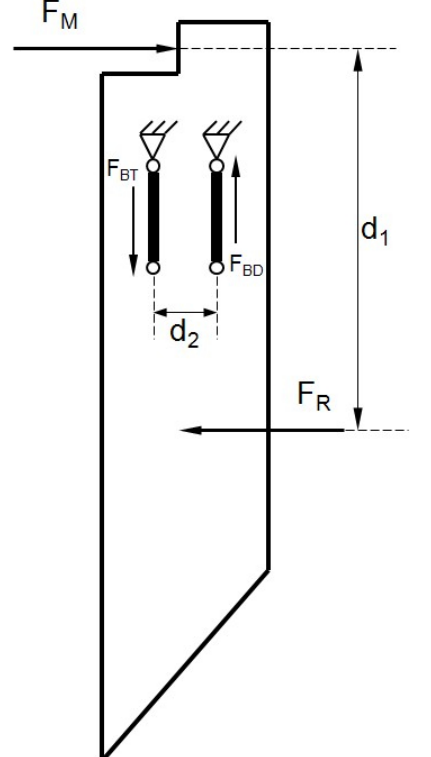
, F and the distances on the cutting R M